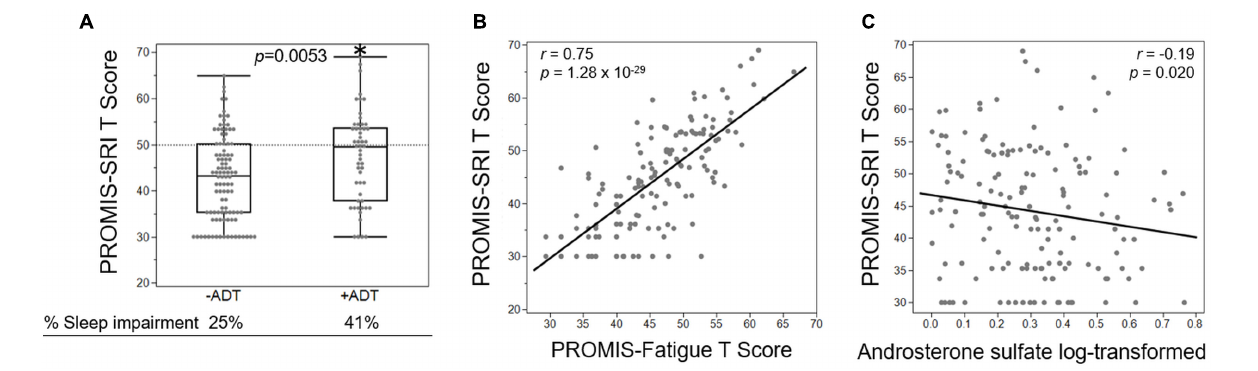
FIGURE 6 | Fatigue severity was associated with ADT-related increase in sleep impairment. (A) Box plot showing the PROMIS-SRI T scores of the − ADT PROMIS-Fatigue T -scores of the − ADT group (42.67 ± 9.24) and the +ADT group (47.2 ± 9.95). *Indicates statistical significance ( p = 0.0053). Scores above the dotted lines are considered fatigued (25% of − ADT, 41% of +ADT). (B) PROMIS-SRI T -score was highly correlated with PROMIS-Fatigue T -score ( r = 0.75, p = 1.28 × 10 - 29 ). (C) Androsterone sulfate levels significantly correlated with PROMIS-SRI T -scores ( r = –0.19, p = 0.020).